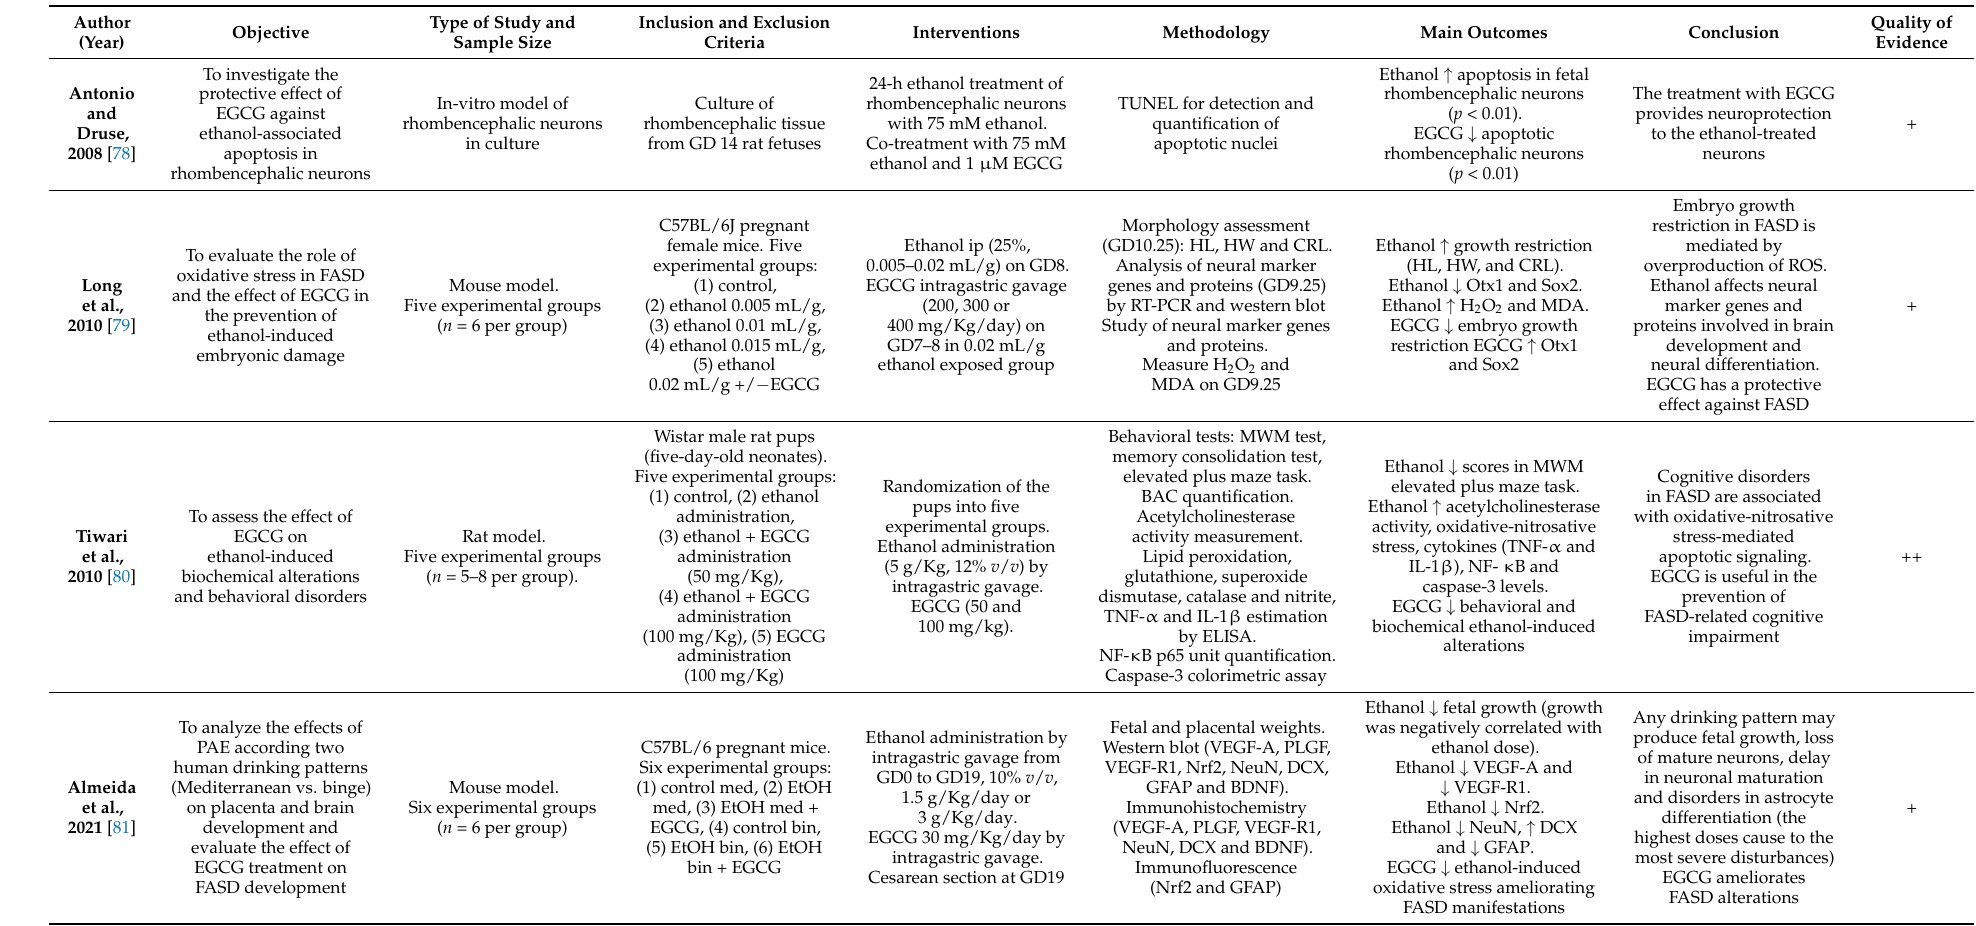
Table 2. Catechins in fetal alcohol spectrum